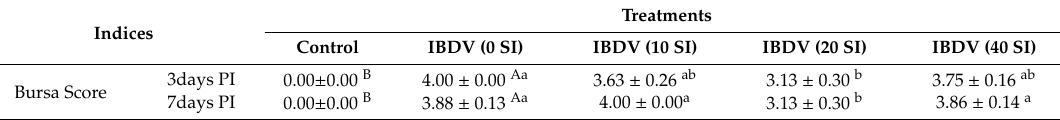
Table 5. E ff ect of adding soy isoflavones on bursa lesion score of IBDV-challenged broilers 1 .